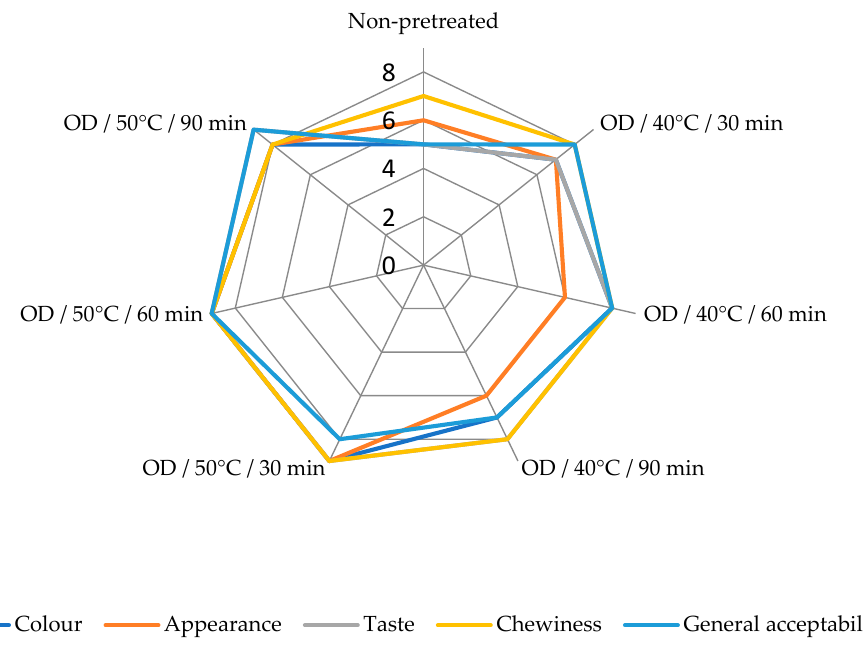
Figure 4. Sensory properties of dried kumquat slices